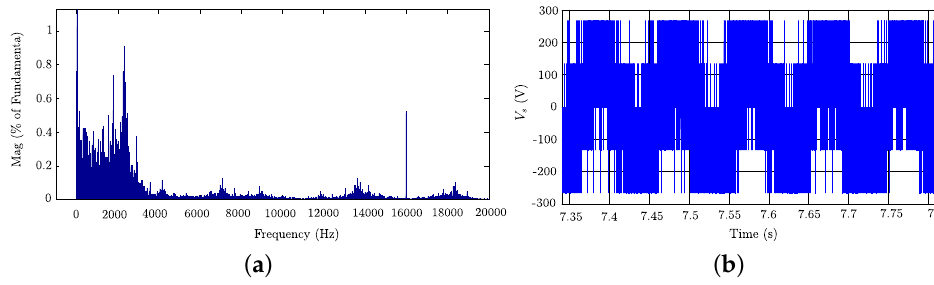
Figure 8. Experimental performance for PFSCCS at 8 kHz of sampling frequency and 500 rpm: ( a ) Spectrum of the measured stator current; ( b ) Switching pattern in the VSI.